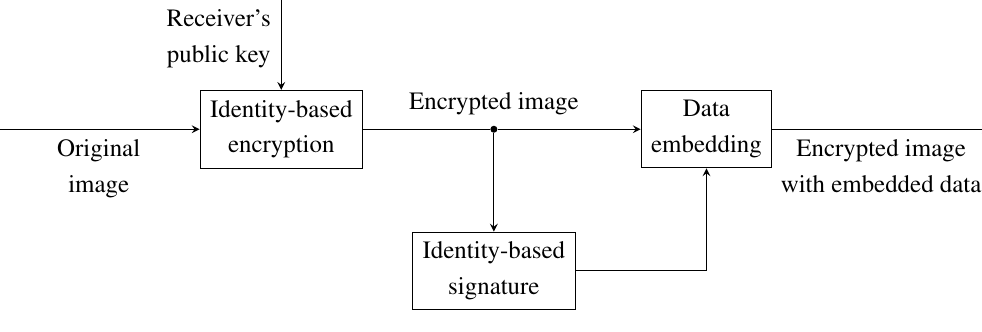
Figure 2. An usage